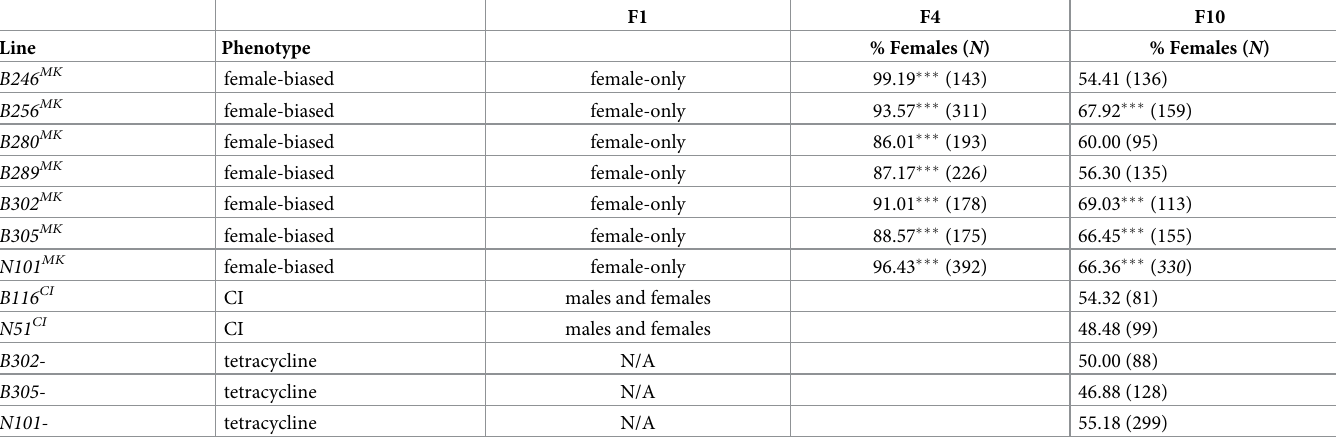
Table 2. Sex ratios of female-biased lines over the first 10 generations of laboratory maintenance.